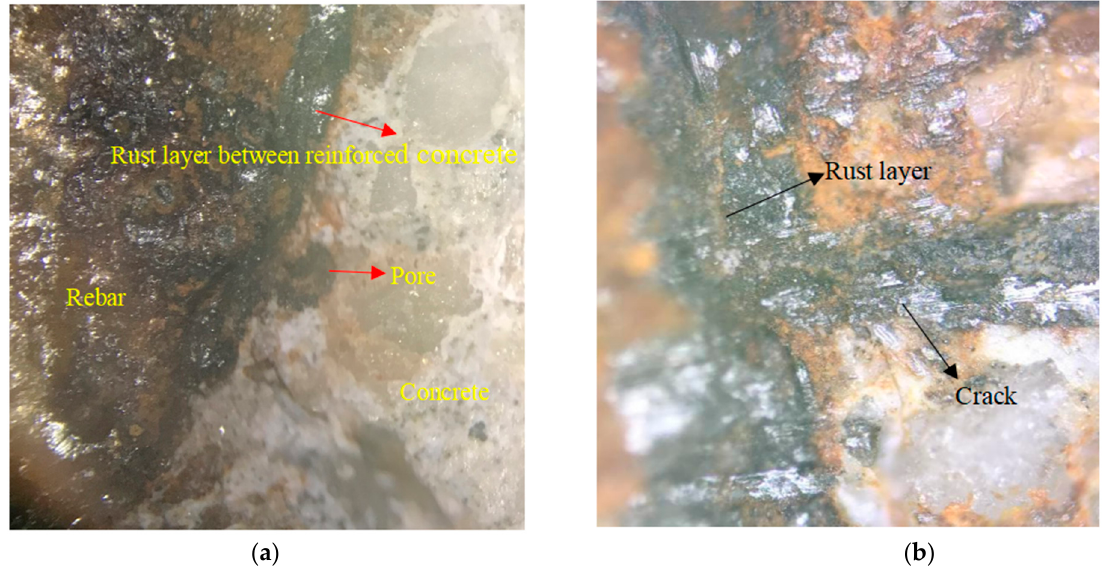
Figure 9. Distribution of corrosion products in a reinforced concrete section. ( a ) Corrosion products of the concrete interface and pore; ( b ) corrosion products of reinforced concrete interface and cracks.